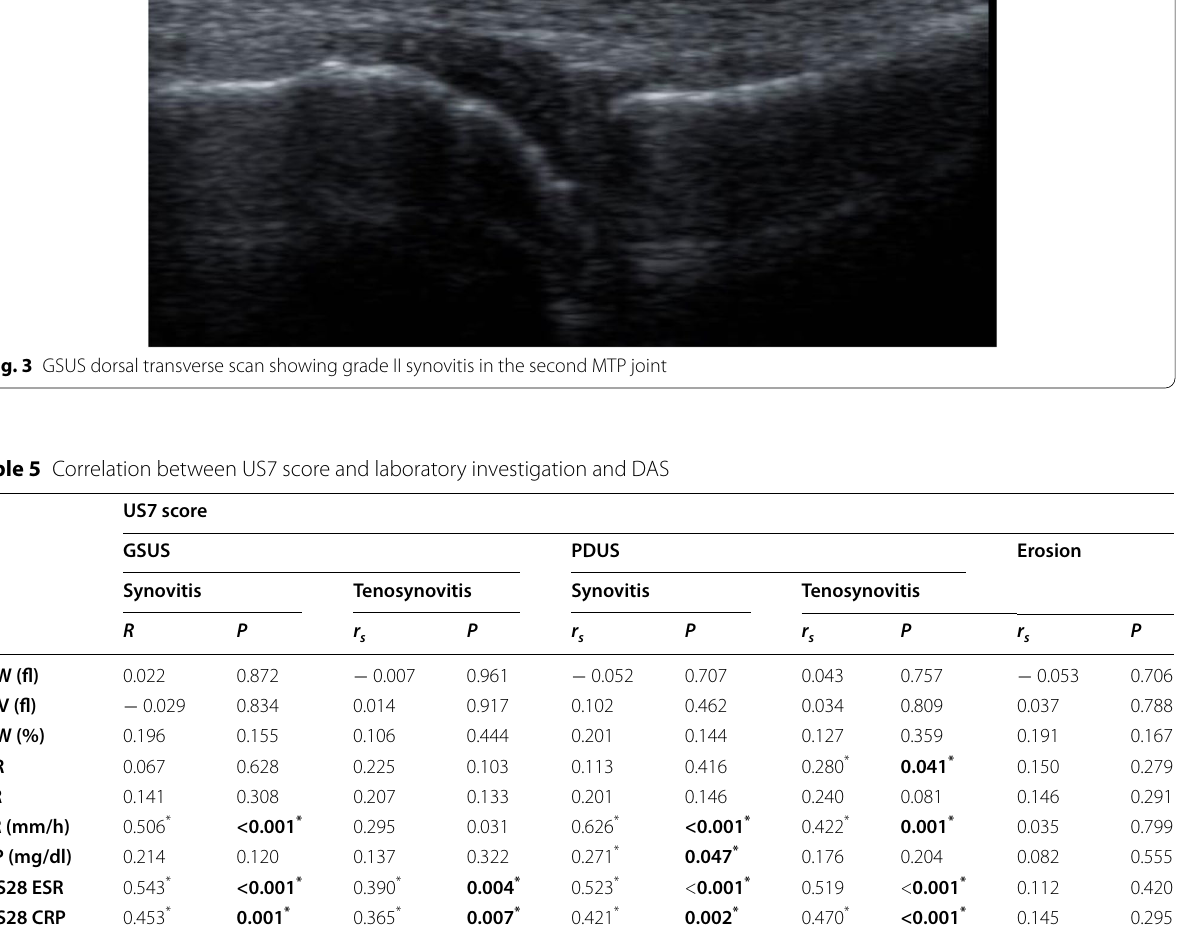
r Pearson coefficient, r s Spearman